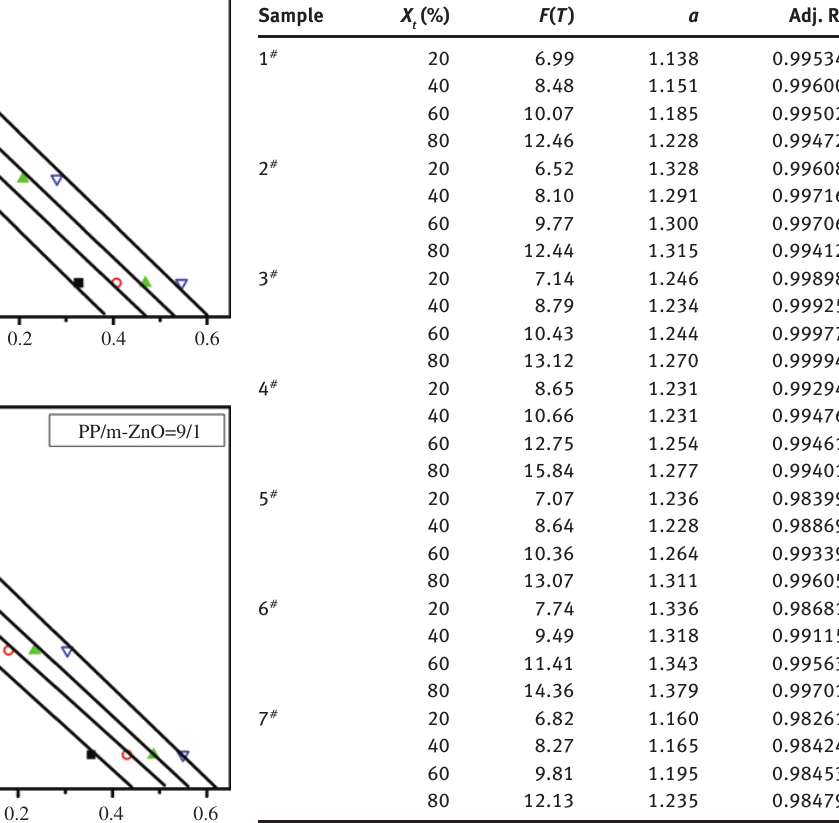
Table 2 Values of F ( T ) and a for PP/ZnO composites based on combined Avrami and Ozawa.